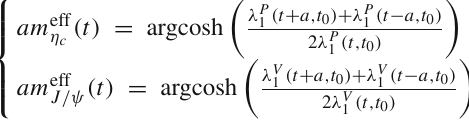
Fig. 3 Effective mass of the ψ( 2 S ) state extracted from the correlator ˜ C 2 (right plot) to project C V L V along the first excited state generalized eigenvector v V